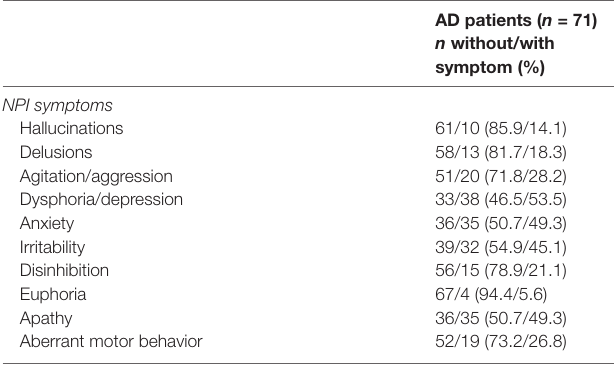
TABLE 2 | Frequency of NPI symptoms.